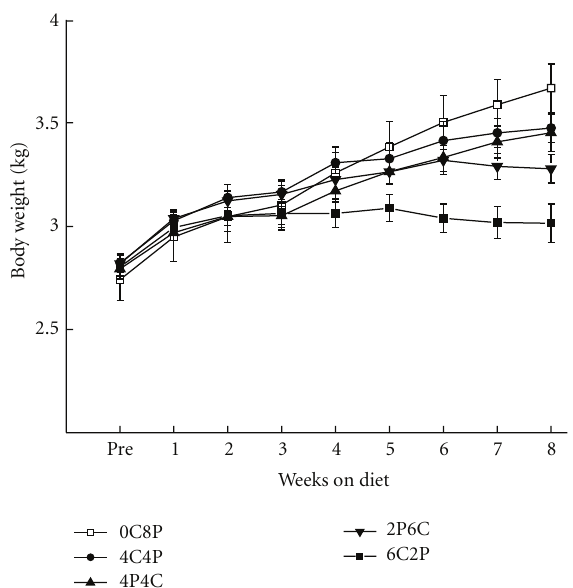
Figure 4: Mean ( ± SEM) body weight for rabbits upon arrival (Pre) and across the eight weeks of their respective diets in the 6CP2, 2PC6, 4C4P, 4P4C, and 0C8P groups where the numbers in the group designation refer to the number of weeks out of eight the rabbits were on either a 2% cholesterol diet (C) or on normal Purina rabbit chow (P). The order of the letters and refers to order in which rabbits received their respective